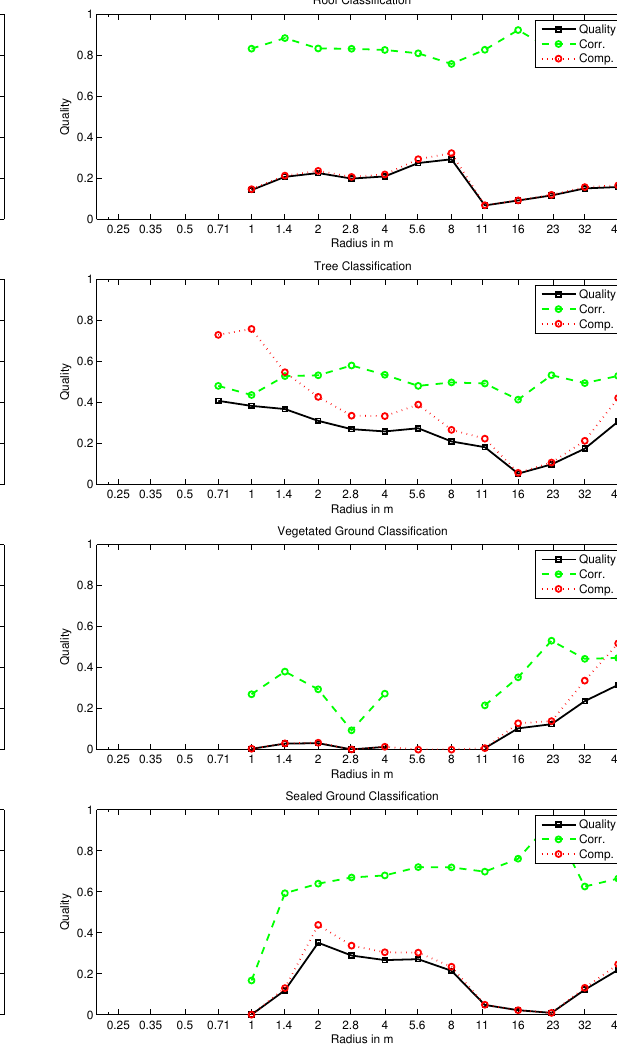
Figure 3: Evaluation of classification results exclusively employ- ing covariance features for different neighbourhood sizes. As explained in Section 4.2.1 the quality increase above 16m radius is not reliable outside of reference areas. subset per neighbourhood for covariance calculation, did not dis- play an increase in completeness and quality for high neighbour- hood radii but were otherwise identical. Therefore increased